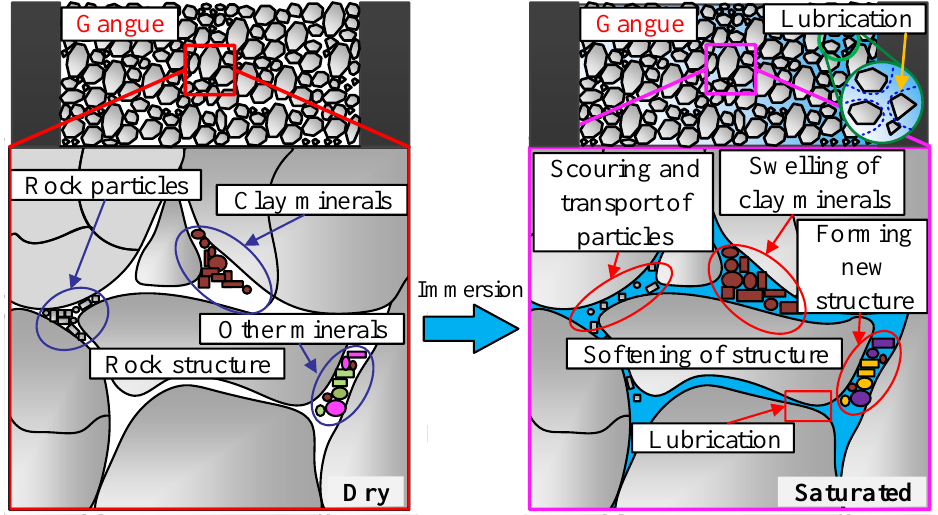
Figure 2. Schematic diagram of the water ‒ rock interaction after gangue soaking.